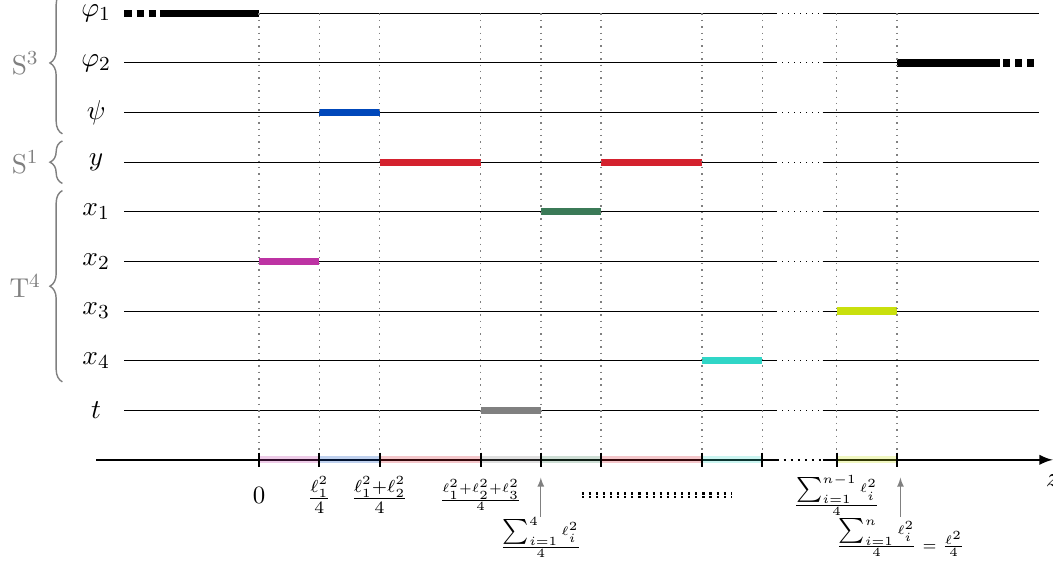
Figure 17 . Rod diagram of the shrinking directions on the z -axis after sourcing the solutions with n connected rods that correspond to regular coordinate